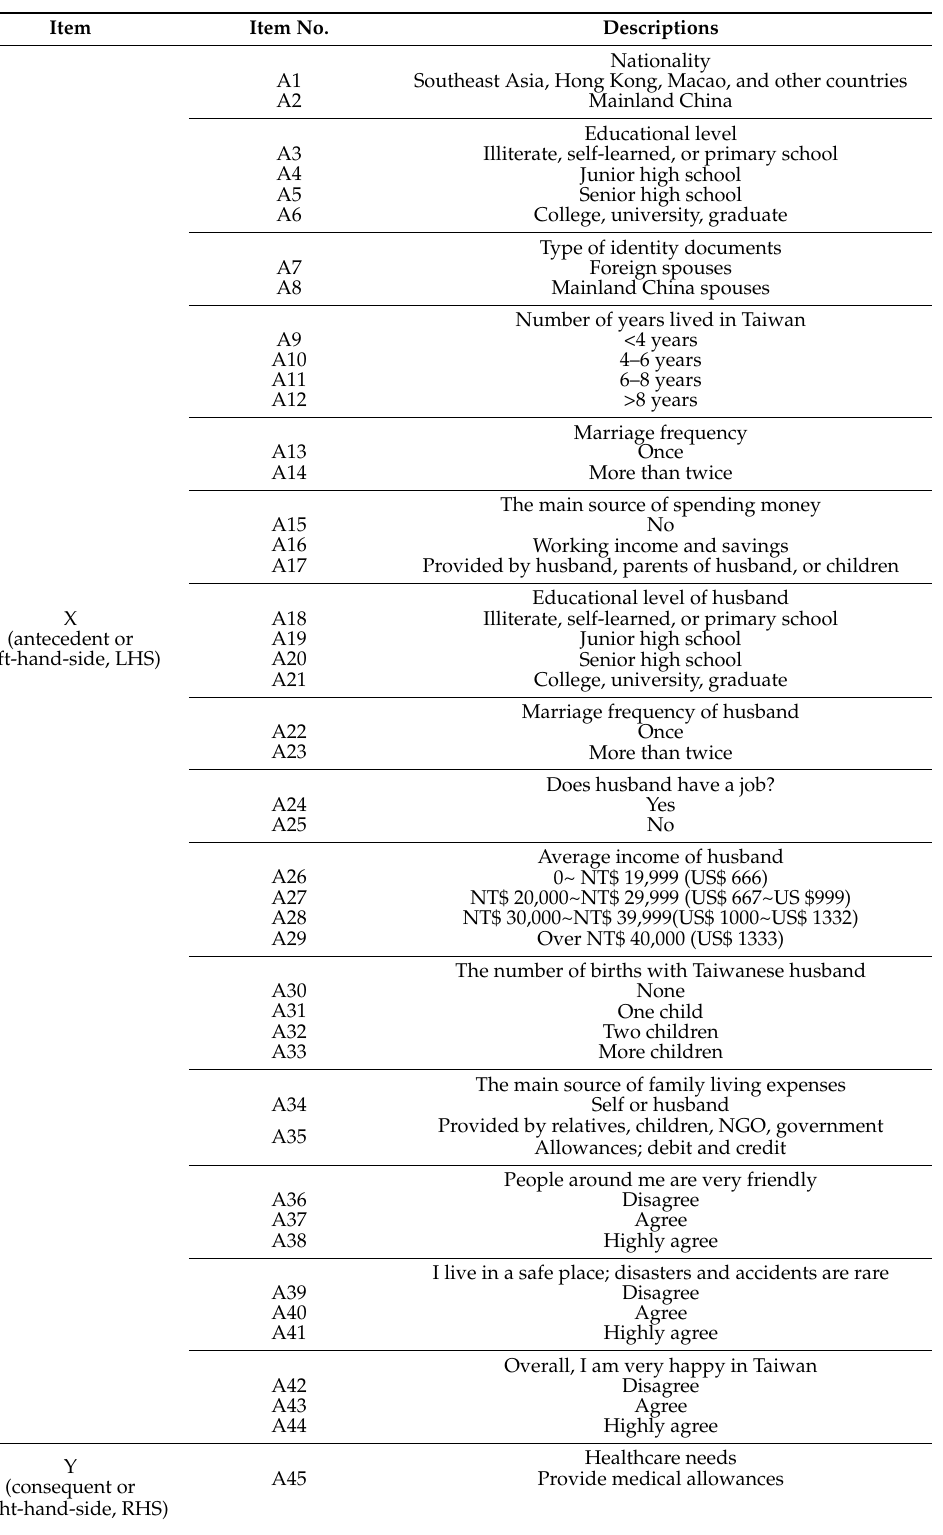
Table 3. Items regarding the socioeconomic characteristics (X) and healthcare needs (Y) of immi- grant